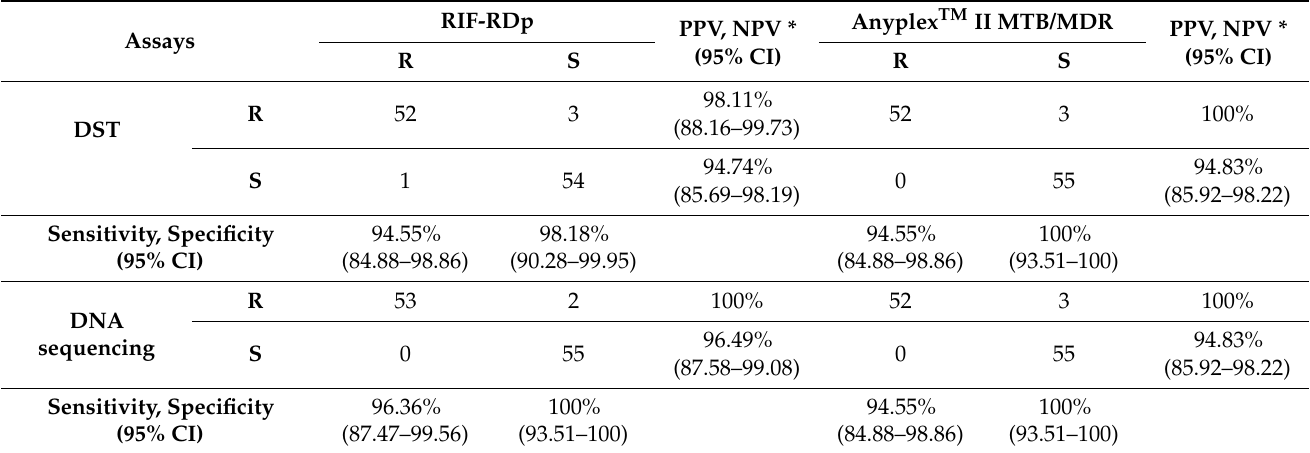
Table 2. Comparison of the performance between the RIF-RDp assay and Anyplex™ II MTB/MDR in the detection of rifampicin-resistant tuberculosis against drug susceptibility testing (DST) and DNA sequencing